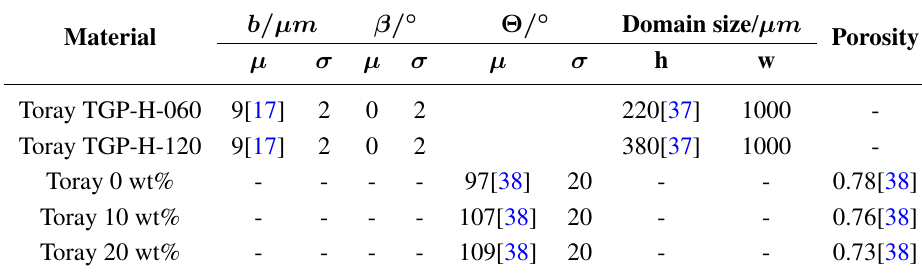
Model input parameters for Toray paper GDLs with different thicknesses (TGP-H-060 and TGP-H-120) and PTFE contents (0 wt%, 10 wt% and 20 wt%). µ is the mean value; σ is the standard